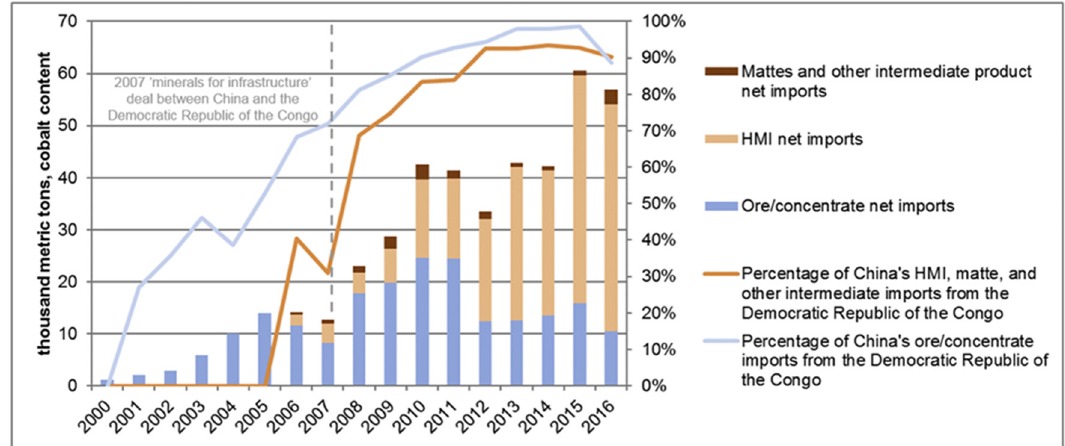
Figure 1. Percentage of cobalt content imported from the Democratic Republic of the Congo. HMI is referred to as hydrometallurgy intermediate